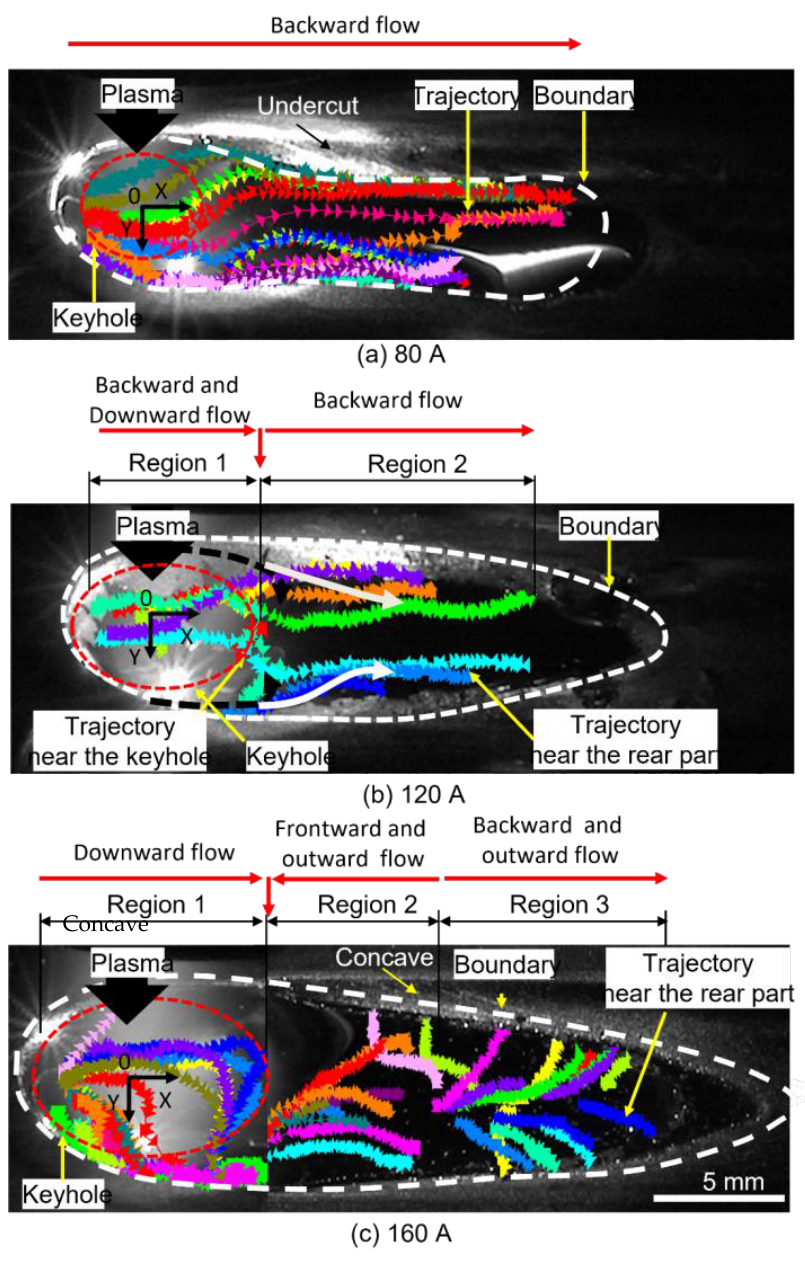
Figure 6. Material flow dynamic on the melted domain surface: ( a ) for 80 A; ( b ) for 120 A; and ( c ) for 160 A In the case of 80 A, particles were moved from the front part of the keyhole toward the rear part of the keyhole. All particles were strongly accelerated in the upward direc- tion from inside the keyhole center toward the top surface behind the keyhole and contin- uously moved in a backward tendency with gradually decreasing velocity before stop- ping at the ending region of the melted domain. Most particles were focused on straightly